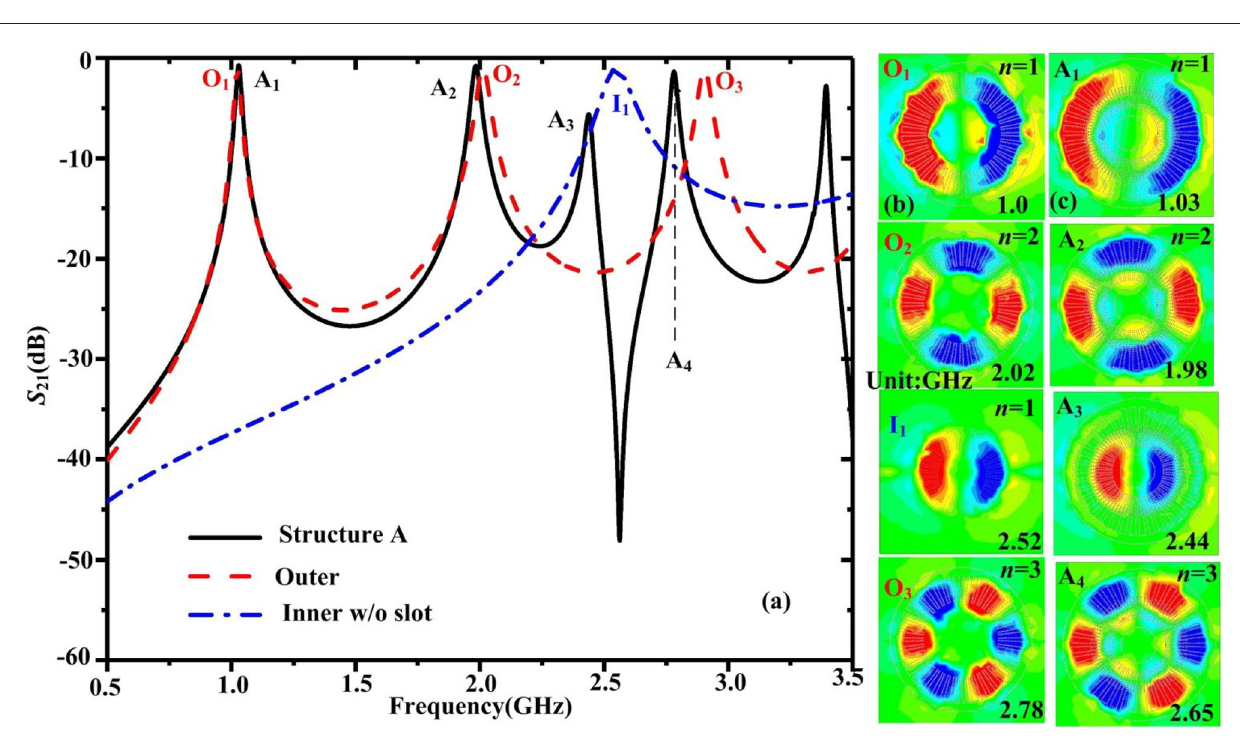
is GW Instek linear DC power supplies GPS-1850D. Figure 5a illustrates the schematic of the active two-way Fano resonance switch, where an SBD diode is mounted across the slit in the inner corrugated ring. The capacitance is used to isolate the DC signal, whereas the inductance is used to isolate the AC